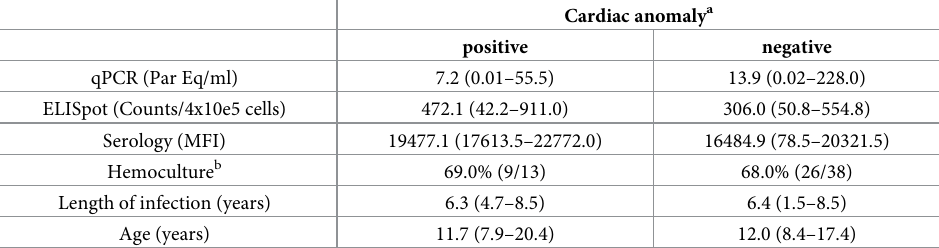
Table 1. Parasitological and immunological parameters in macaques displaying cardiac anomalies.